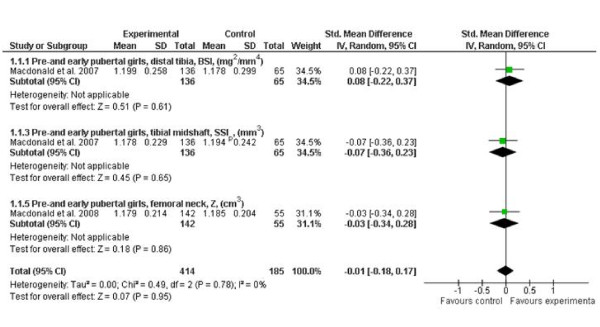
Effects of exercise on indices of bone strength (standard mean difference, 95% CI) in young girls at the distal tibia, tibial shaft and femoral neck. The squares and diamonds represent the test values for individual studies and the overall effect, respectively.